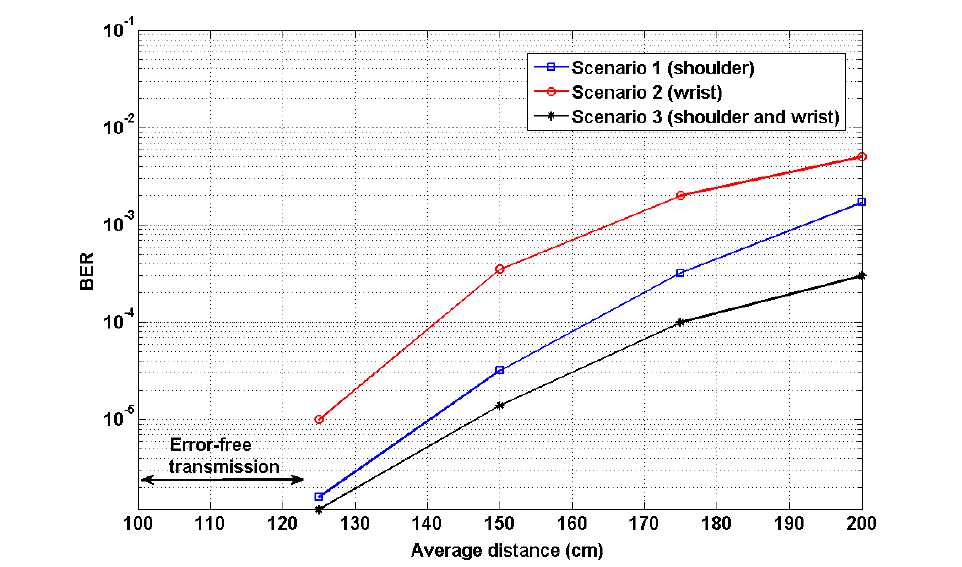
Figure 11. Performance analysis: BER versus transmission